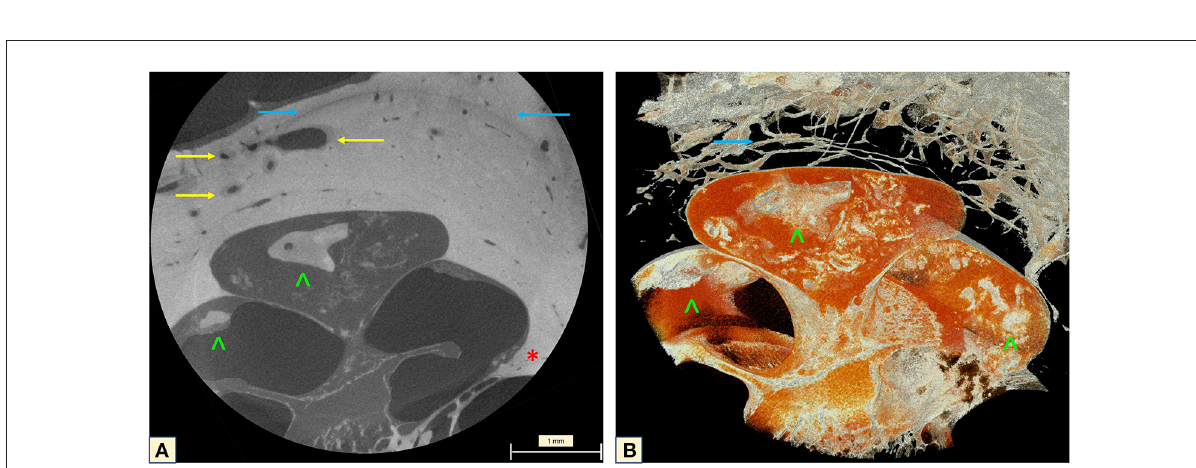
FIGURE6 MicroCT of the cochlear apex (2.48 µ m). (A) Neovascularization with enlarged vessels in the region of the otospongiotic bone (yellow arrow). The classic halo sign with different density of the bony matrix around the cochlea is indicated by the blue arrow. An impressive carp-head-shaped cochleolith is seen on the apex (green arrowhead) as well as intense fibrotic tissue formation. Irregularities are visible on the bony cochlear wall at the transition zone to the spongiotic bone (red star). (B) Mesh reconstruction of the apex demonstrating the high vascularization of the halo region (yellow arrows) and the lithic plaques (green arrowheads). The orange image taking over the apex compartment corresponds to the fibrotic tissue seen on the microCT.